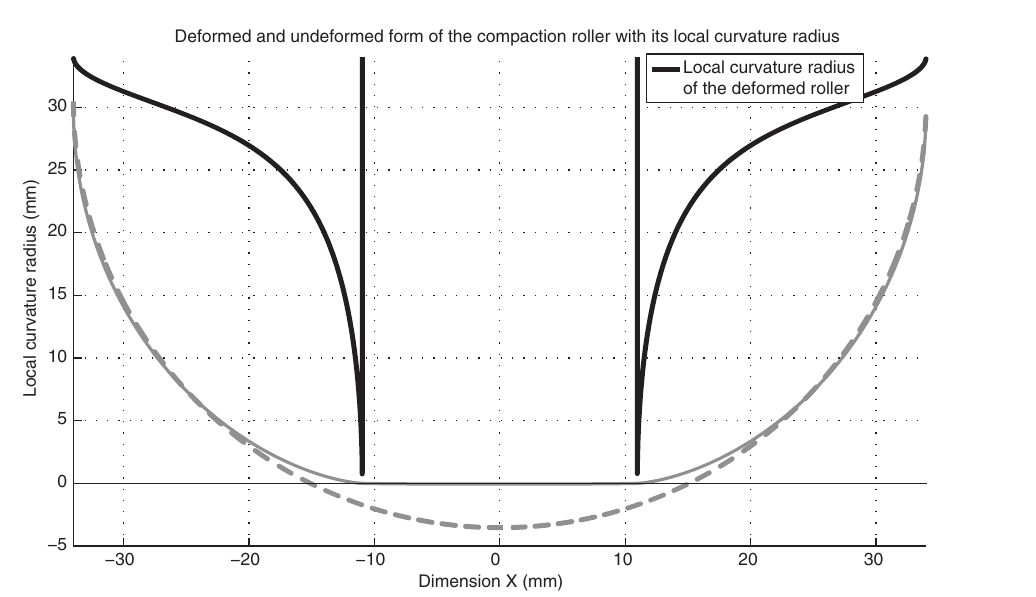
Figure 3 Roller indentation and local curvatures at 90 ° path angle from theory of Hertz